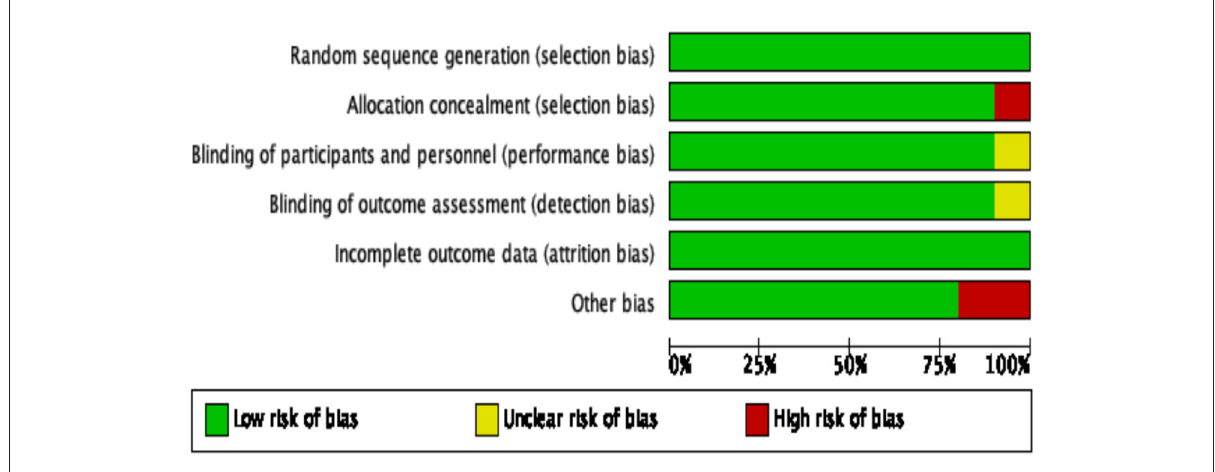
FIGURE2 Graphic representation of risk of bias in randomized control trials assessing the effects of 4-aminopyridine on the management of spinal cord